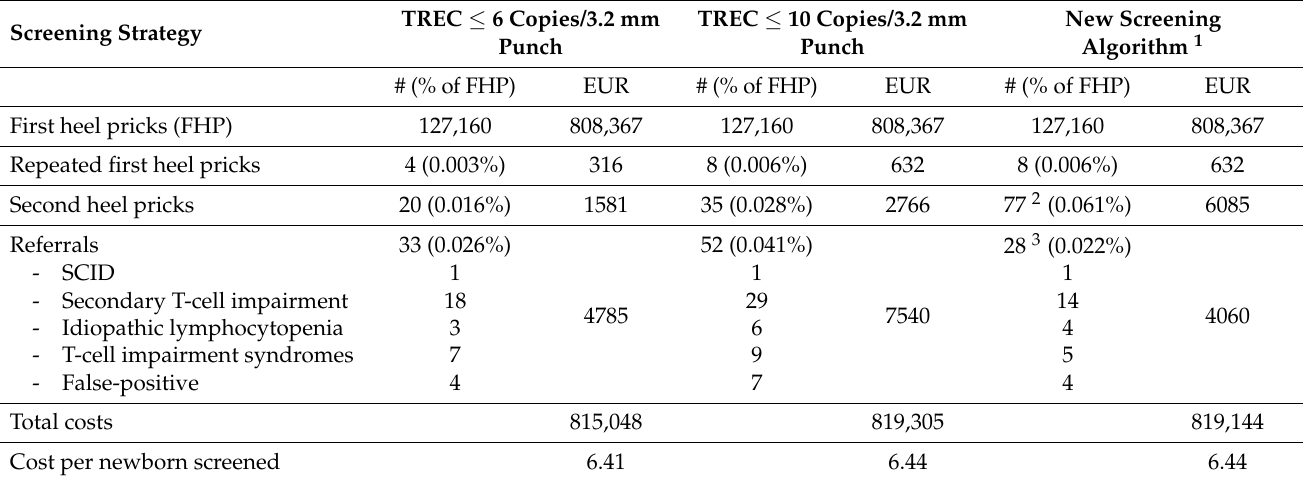
Table 2. Number of 1st heel pricks, repeated 1st heel pricks, 2nd heel pricks, and referrals and cost of screening based on SONNET trial in the period 1 November 2018 to 31 July 2020 (in 2020 euros). Screening